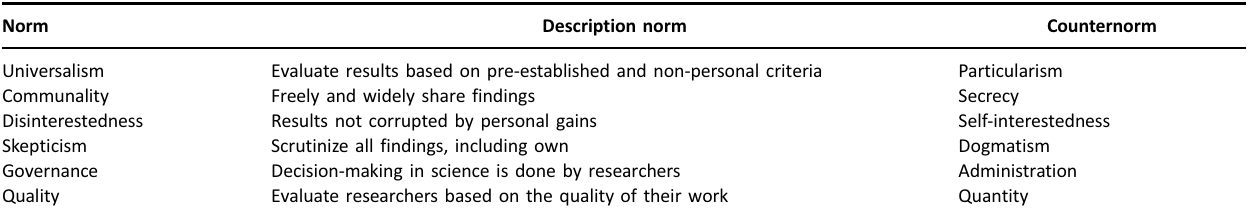
Table 1. Six norms of responsible conduct of research and their respective counternorms (Anderson et al., 2010; Merton, 1942; Mitroff,